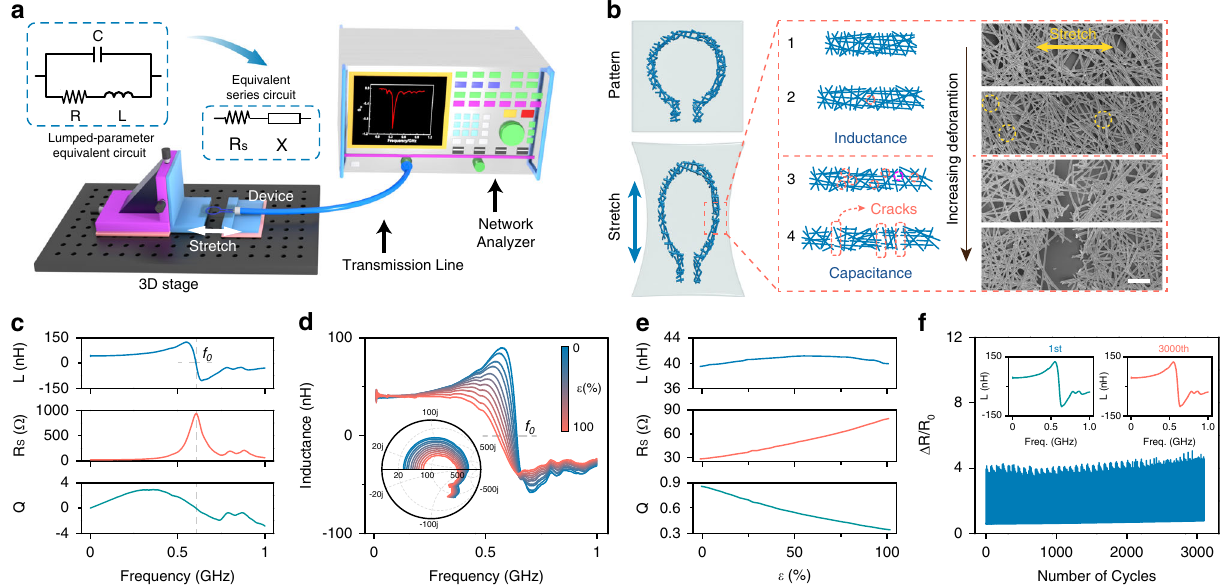
Fig. 2 Radio frequency (RF) properties of the coil under tensile strain. a Schematic of the experimental setup and equivalent inductance model of Ag NFs coil. b Schematic diagram and SEM images of the evolution of the Ag NFs under different tensile strains. c Inductance L , resistance R S , and quality factor Q versus frequency for single-turn coil shown in b . d Inductance variation versus tensile strain for the single-turn coil. Inset: Smith chart of single-turn coil. e Inductance L , resistance R S , and quality factor Q versus tensile strain at 10 MHz. f Stability measurement of single-turn coil. The cycle period is over 3000 cycles for ε = 100%. Insets: inductance before and after cyclic